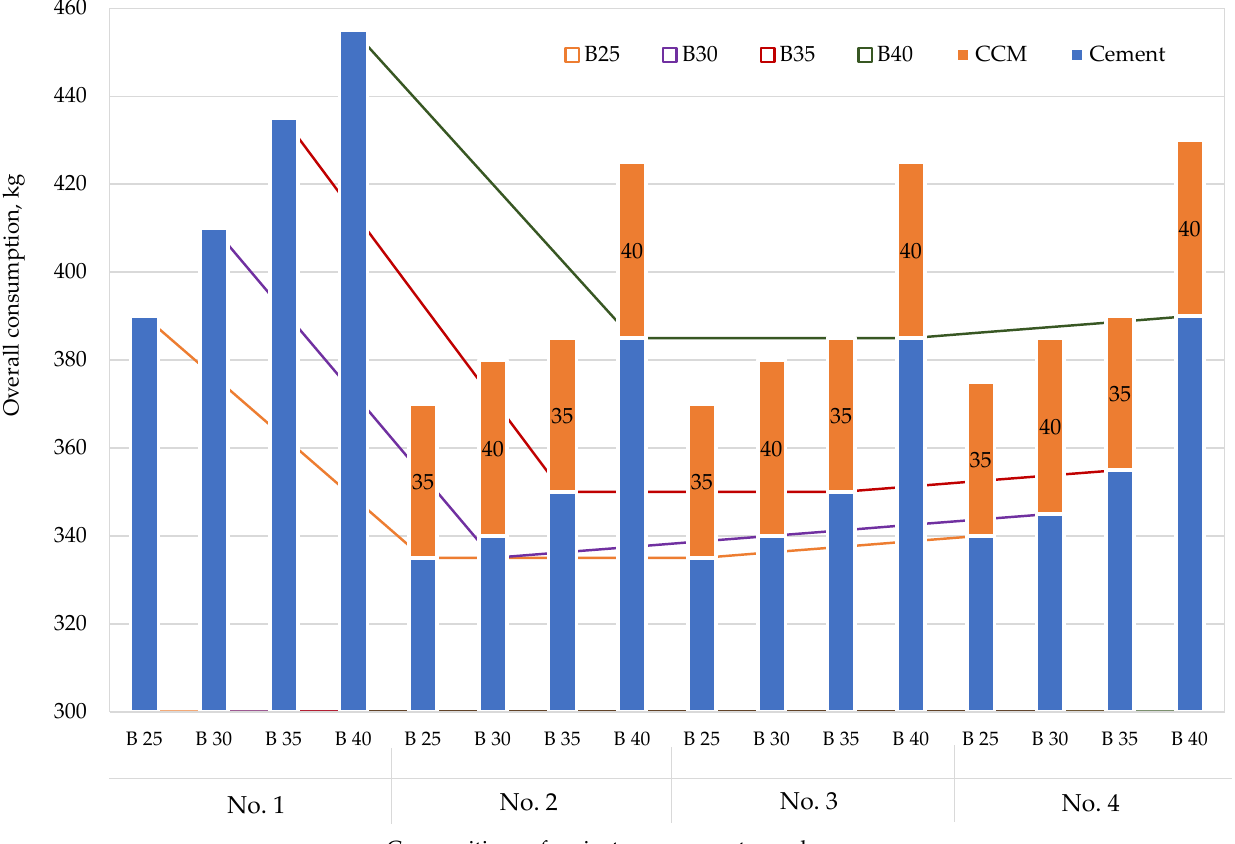
Figure 2. Effect of the modifier on cement consumption: No. 1—no additives; No. 2—with CCM; No. 3—with CCM and HPC; No. 4—with CCM, HPC, and fiber.